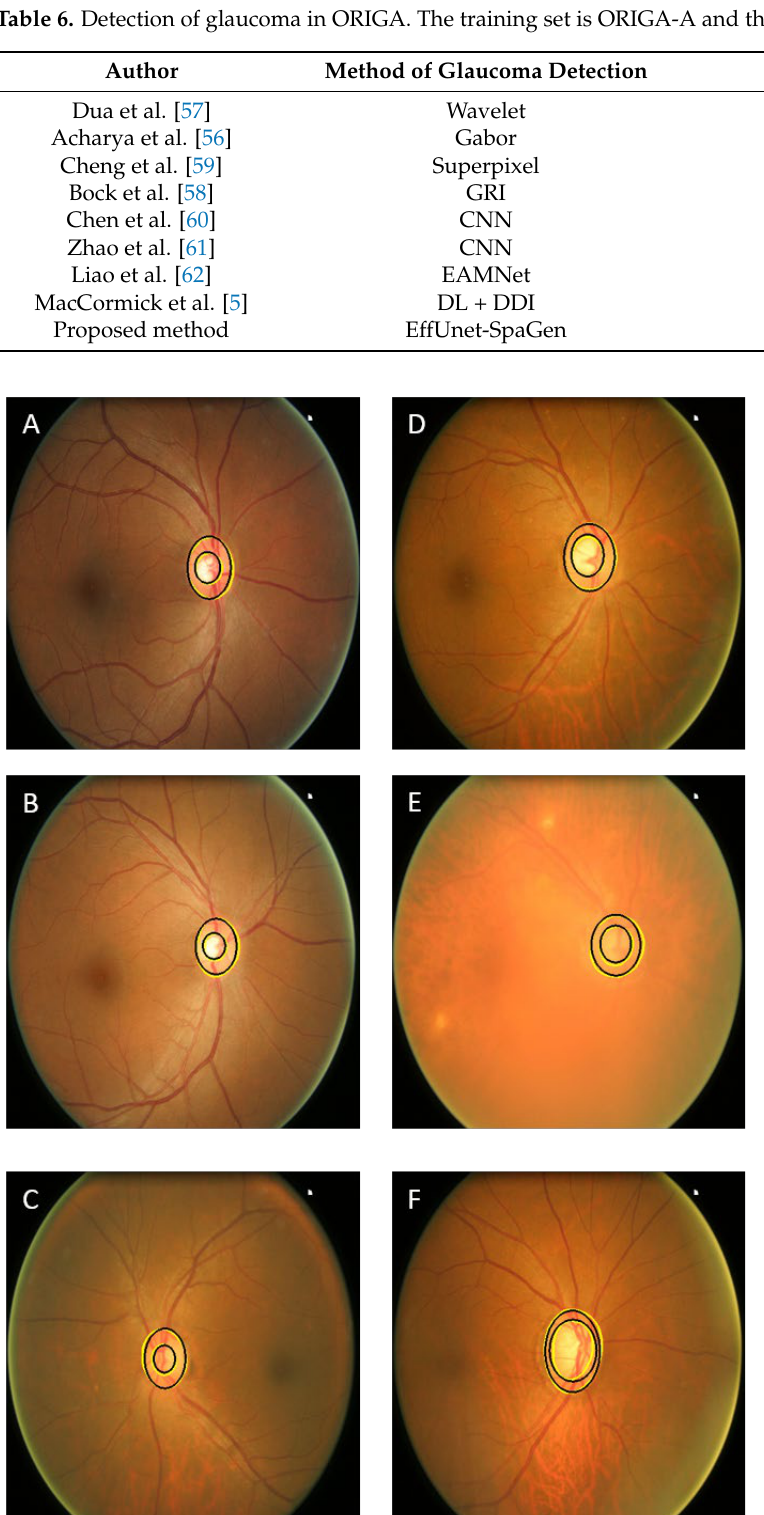
Figure 7. Visual results of several images of normal eyes ( A – C ) and glaucomatous eyes ( D – F ). The challenging images are E , C and F . The black contours show the manual annotation and yellow contours show the results of our segmentation approach.